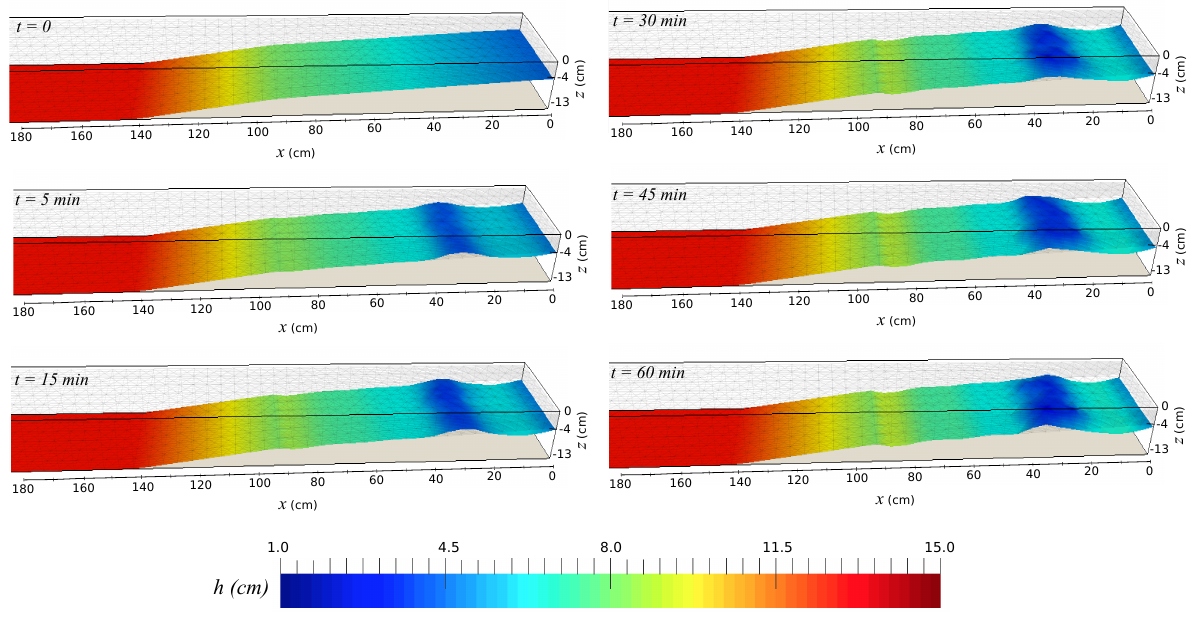
Figure 13. Numerical results of bathymetry evolution for Test